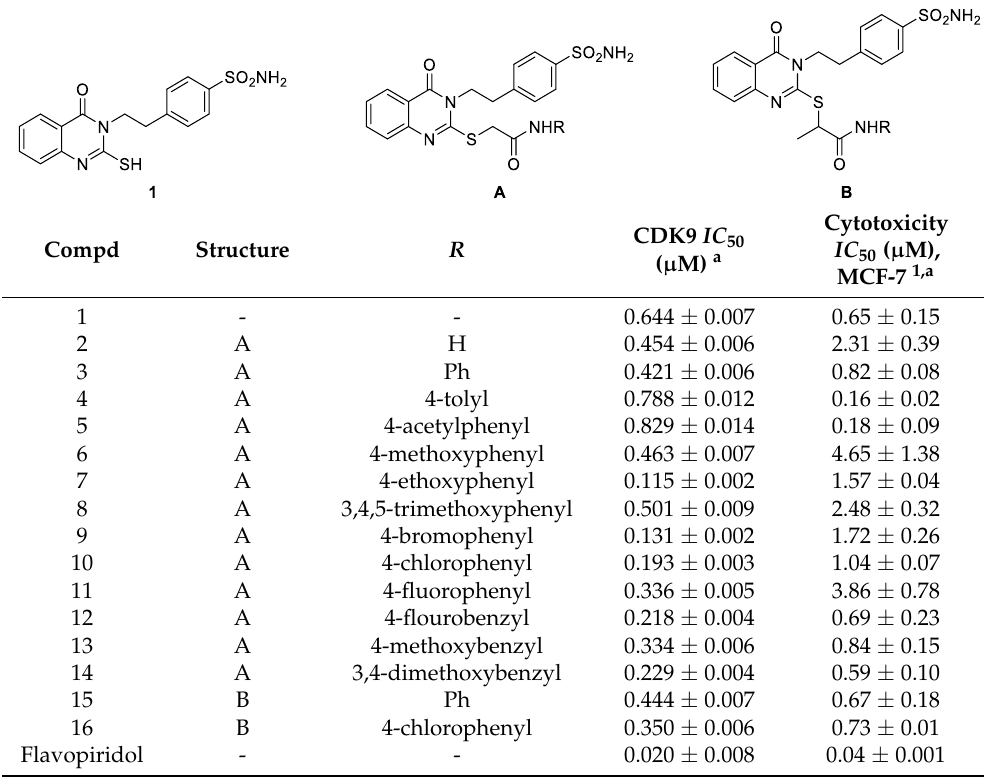
shows promising CDK9 inhibitory activity with an IC 50 value of 0.644 μM [39]. Therefore, it was selected as a hit compound and modified with different substituents at the quinazoline position 2 to improve its inhibition properties. The results show that introducing acetamide and acetanilide groups at position 2 in compounds 2 and 3 showed better inhibition than the hit compound, with IC 50 values of 0.454 and 0.421 μM, respectively, as shown in Table 1. To investigate the effects that other functional groups substituted at the p -position of the acetanilide ring have on improving the potency of the compound, analogs 4 − 8 with various substituents, such as methyl, acetyl, methoxy, and ethoxy groups, were prepared and evaluated. Compound 4 , with a p-methyl group, displays lower inhib-